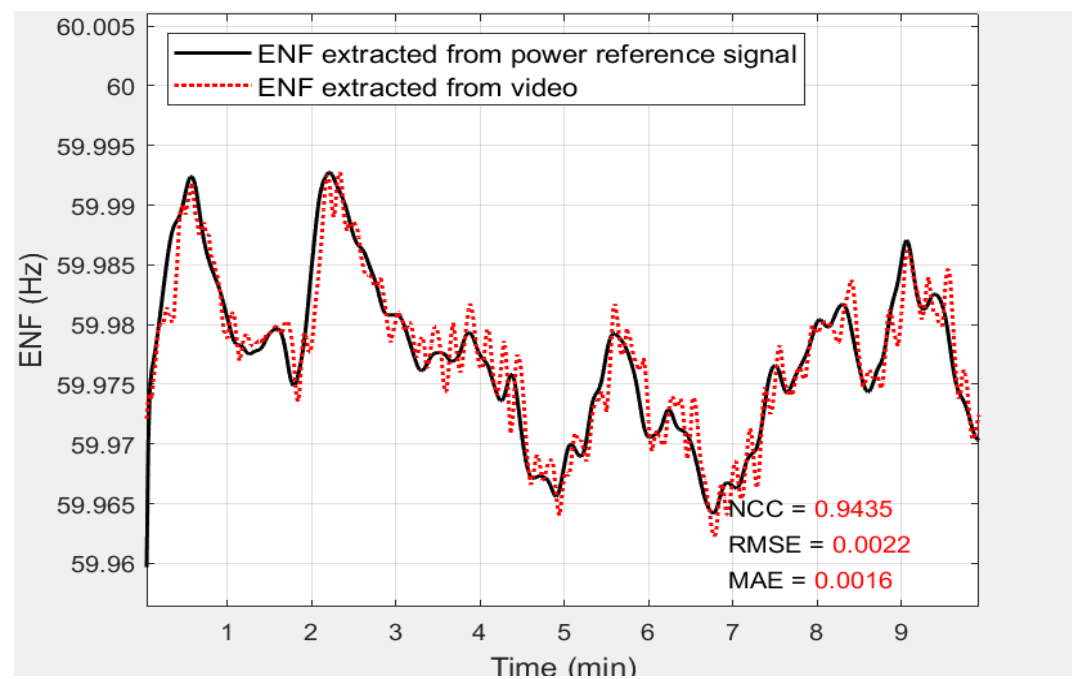
Figure 6. Sample of the ENF signal extracted from a video file (red) using a 𝑇 𝑟𝑜 value of 13.4 ms (Sony Cybershot DSC-RX 100 II) and matched against the reference signal (black). The bottom right corner shows the measure of similarity and dissimilarity between the extracted signal and the reference signal.